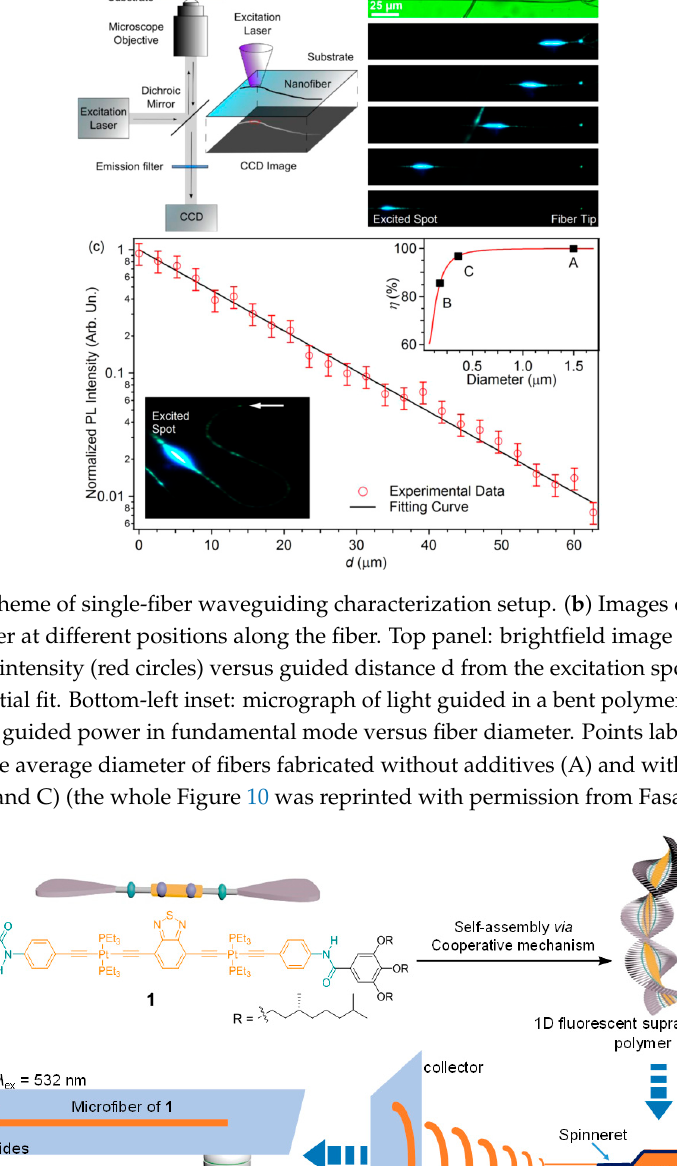
10 of 21 Figure 9. Waveguiding micrographs of polymer spun fibers in ( a ) controlled atmosphere and ( b ) air, and excited by a focused laser (blue circles). Scale bars = 20 µm. White arrows in ( a , b ) show the fiber tip and defects along the fiber axis, respectively. ( c ) Waveguided PL intensity along a single fiber versus propagation distance d, with fibers electrospun in controlled atmosphere (blue squares) and air (red circles). Dashed lines: exponential fit to decay (the whole Figure 9 was reprinted with permission from Fasano et al. [47]). Many polymer micro/nanofibers electrospun from a single solvent have beaded structures and large diameters. The polymer is not always easily dissolved due to the large molecular weight; a good solvent can prevent aggregation and make the polymer molecules better aligned and oriented. However, good solvents for many polymers often have a low boiling point and poor conductivity, which goes against the electrospinning process. Organic salts and other additives can increase the conductivity without affecting the viscosity and surface tension of the solution and are often used to improve the electrospun fiber waveguiding properties. Pisignano et al. demonstrated that fibers obtained from fluorene-substituted phenylenediamine chloroform solution, to which was added organic salt (tetrabutylammonium iodide), were more regular than those obtained using a single solvent (chloroform); also, the sizes were more uniform and nanofibers with very fine diameters (<10